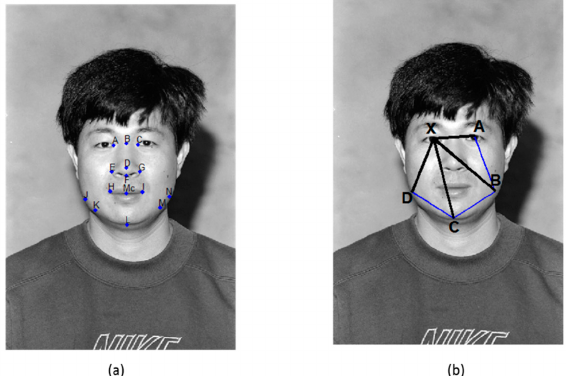
Figure 4. ( a ) Selected fiducial points on image from the FERET database which are used to construct the configural feature vector, ( b ) The cross ratio projection based on a polygon constructed from five fiducial points on face image from the FERET database.